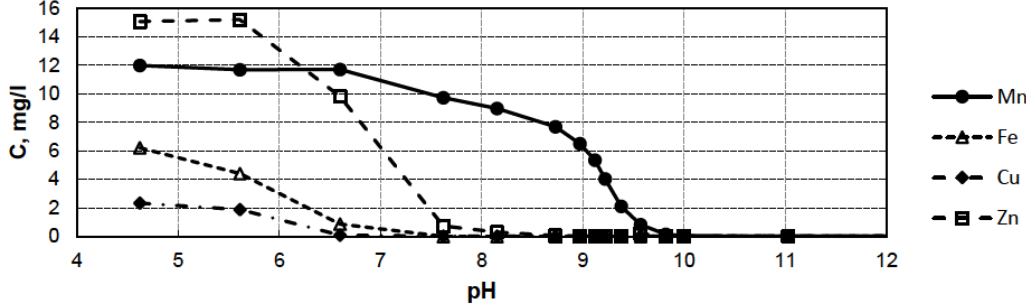
Figure 1: Concentrations of metal ions (Mn 2+ , Fe 3+ , Cu 2+ and Zn 2+ ) in mine water samples as a function of pH (based on the data from Table 1).